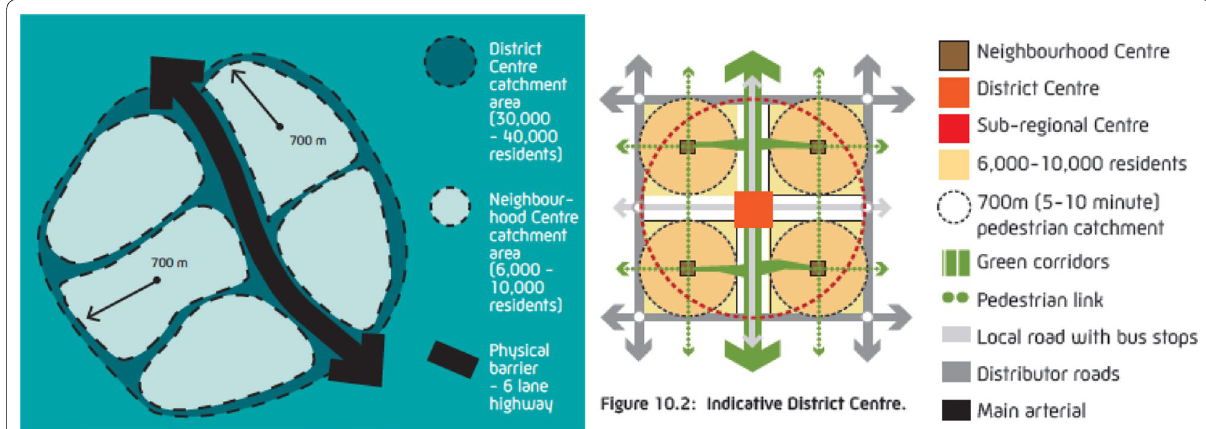
Fig. 2 Catchment distance for neighborhood centers in Abu Dhabi Community Facility Planning Standards ( Source: Abu Dhabi Urban Planning Council